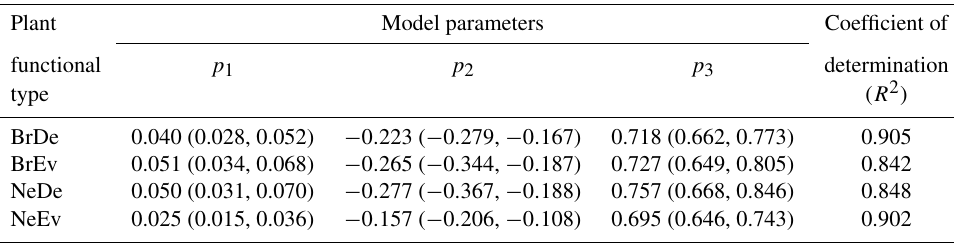
Table 6. Parameters and performance of fitting regression models expressing the degree of damage as a function of the area affected. The relationship between the degree of damage ( y ) and the area affected by wind disturbance ( x ) is expressed by the following general quadratic polynomial function: y = p 1 · x 2 + p 2 · x + p 3 , where p 1 , p 2 and p 3 are the coefficients of the equation. Coefficients are listed in the table with their 95% confidence interval in brackets. Model performance is quantified in terms of coefficient of determination ( R 2 ). Models and the corresponding parameters and performance are evaluated separately for broadleaf deciduous (BrDe), broadleaf evergreen (BrEv), needleleaf deciduous (NeDe) and needleleaf evergreen (NeEv)